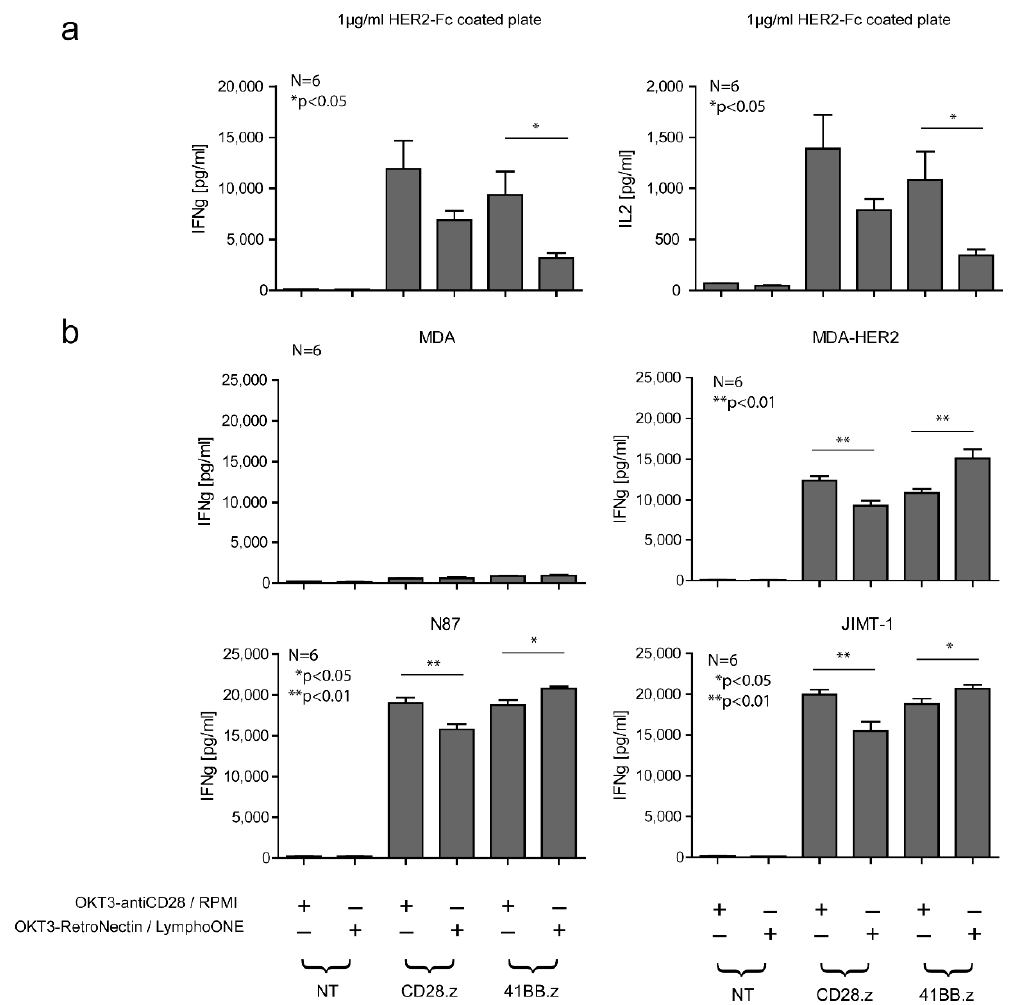
Figure 2. Cytokine release of HER2-CAR T cells prepared with the two different stimulation protocols. ( a ) 2 × 10 5 CD28.z and 4-1BB.z HER2-CAR T cells prepared with the two different stimulation and cell culture protocols were plated onto 1 µg/mL HER2-Fc precoated plates or ( b ) cocultured with MDA-HER2, N87, or JIMT-1 HER2+ target cells at a 1:1 ratio. Following 24 h of culture, supernatant was harvested and analyzed for the presence of IFN γ and IL2 by ELISA. Empty media, NT T cells, HER2+ target cells cultured without the presence of effector cells, and the MDA cell line served as controls. Histograms represent the mean ± SD ( n = 6, OKT3-antiCD28/RPMI vs. OKT3-RetroNectin/LymphoONE : * p < 0.05, ** p < 0.01).